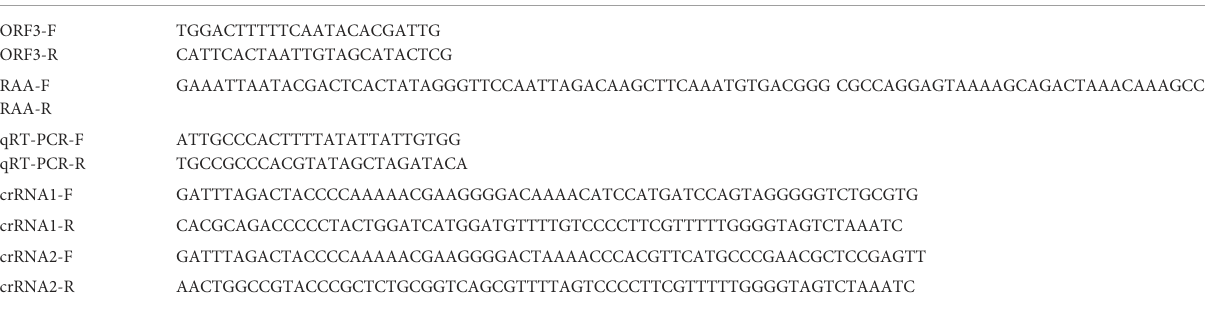
Table 1 The crRNA, primers, and probes used in this